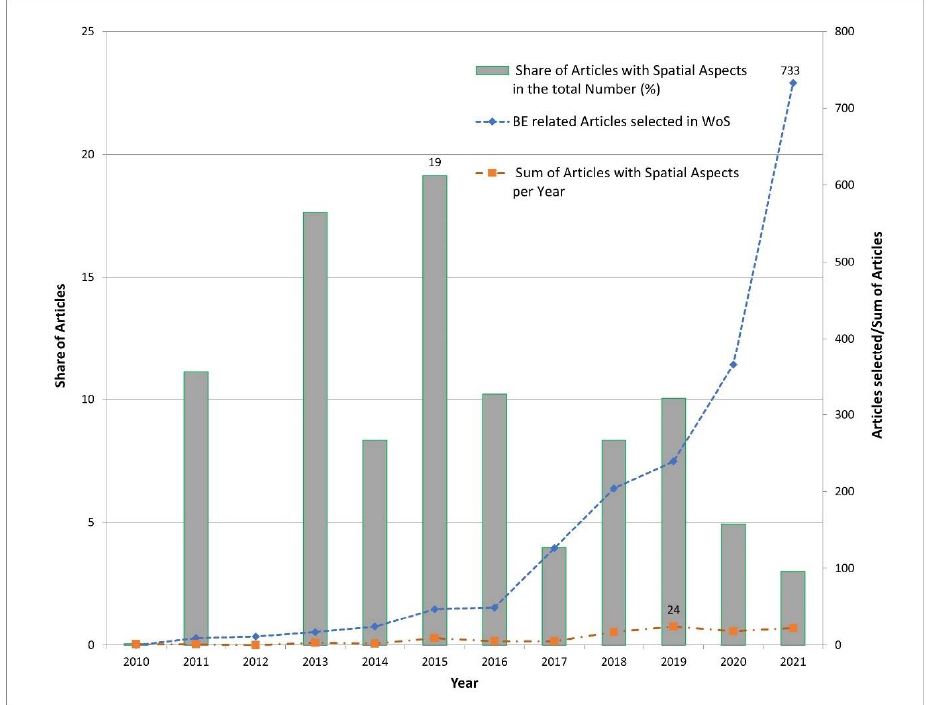
. Figure 3. Distribution of articles over time and percentage of articles with spatial aspects.